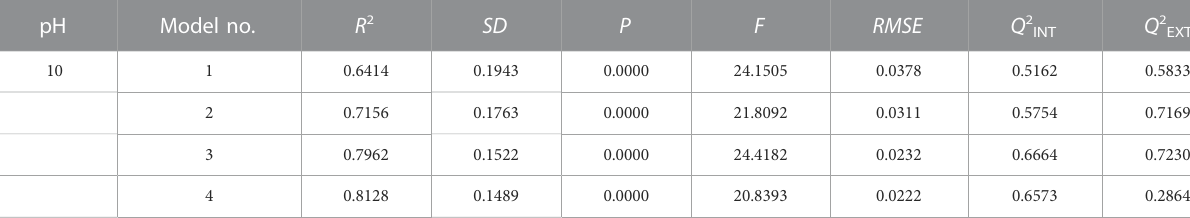
TABLE 3 Statistical indexes of the QSAR models. pH Model no.